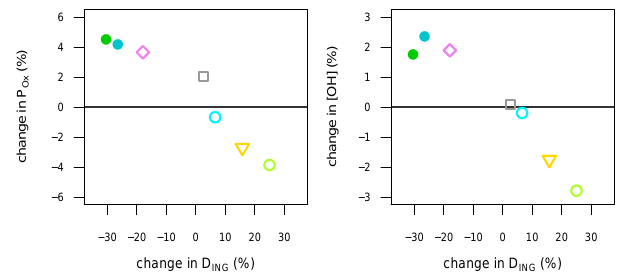
Fig. 8. Correlations between D ING and P Ox (left) and correlations between D ING and OH concentrations (right) from the IS simula- tion and its sensitivity cases. Results are summarized over the entire modeling period for the southeastern US within 2km of the surface. Symbols represent the same sensitivity cases as those described in Fig.